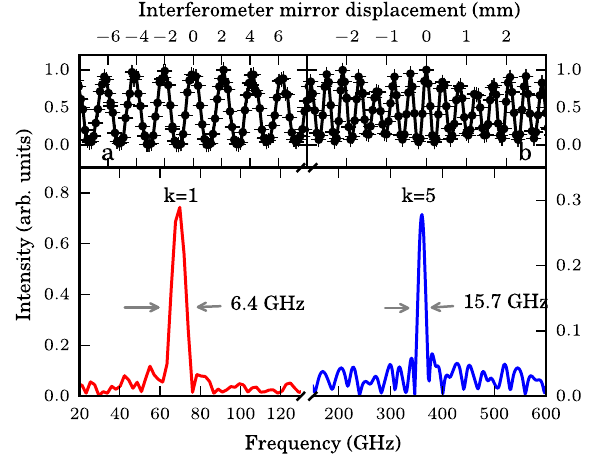
FIG. 3. TR orientation dependence measured in the frequency range 320 – 460 GHz.